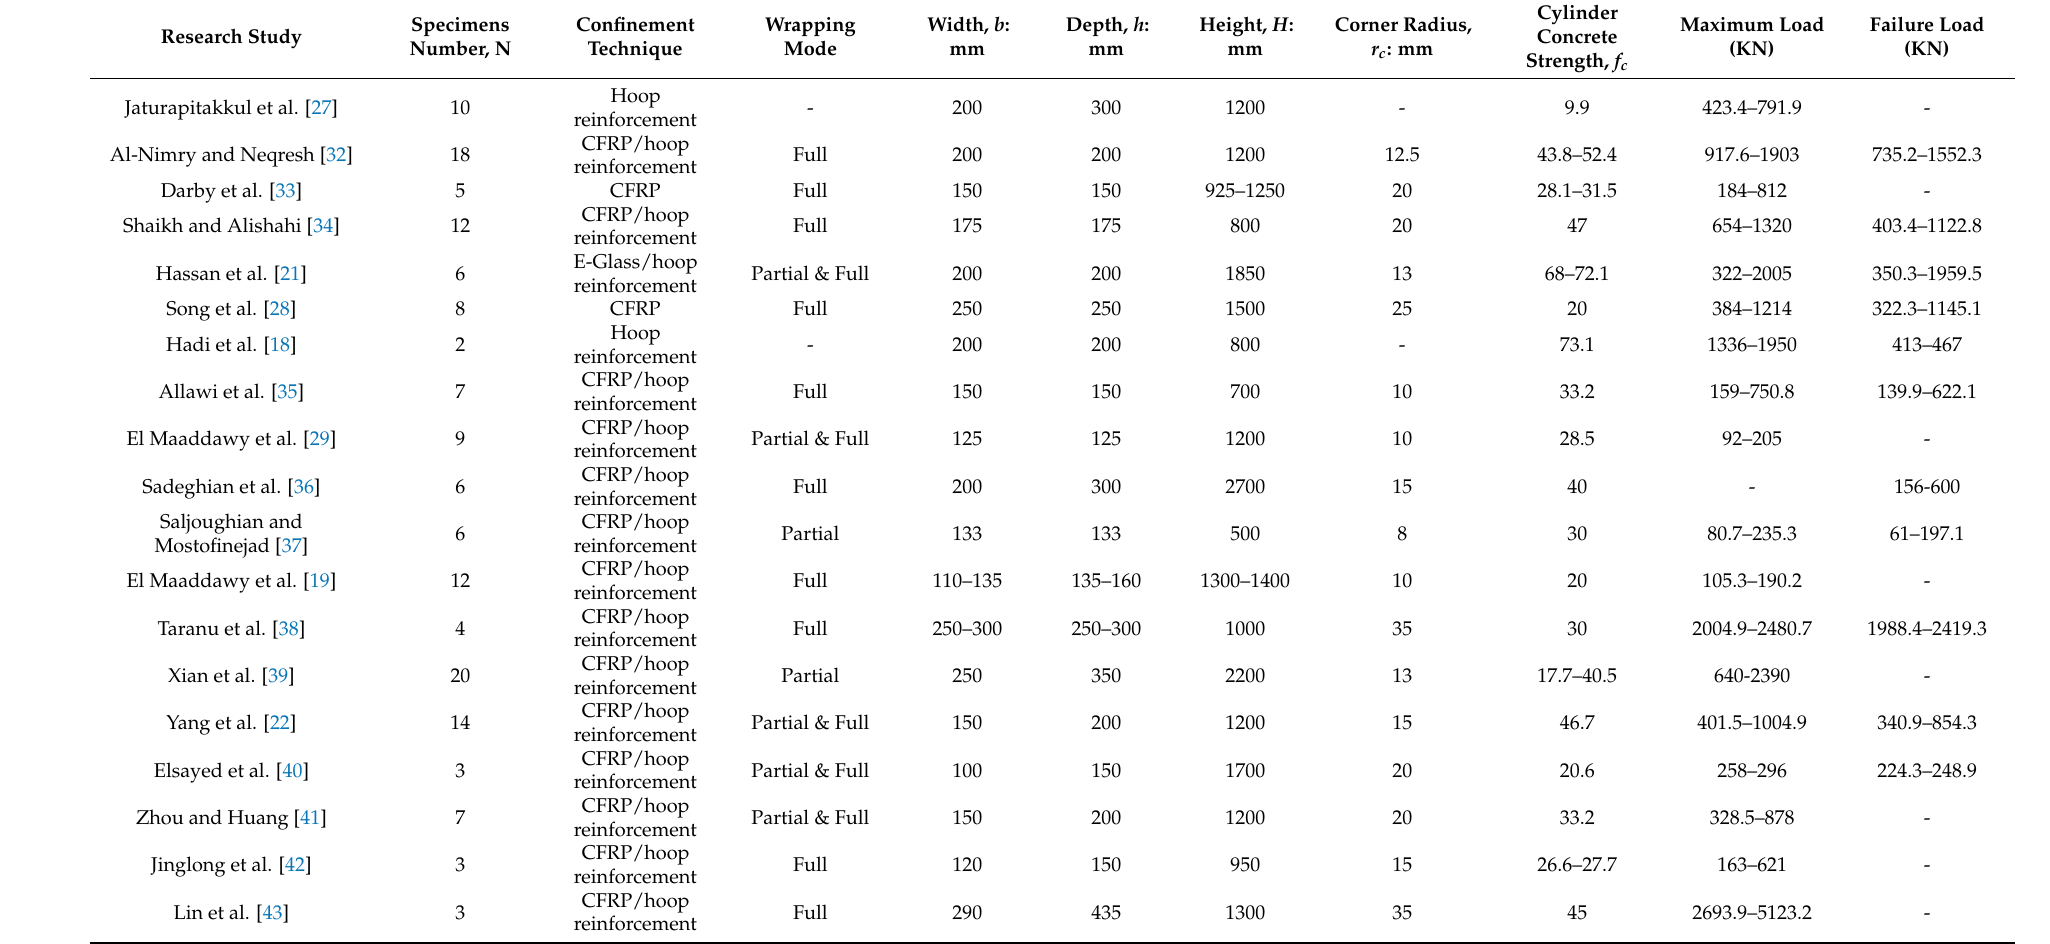
Table 2. Experimental detail of FRP-wrapped unreinforced and RC